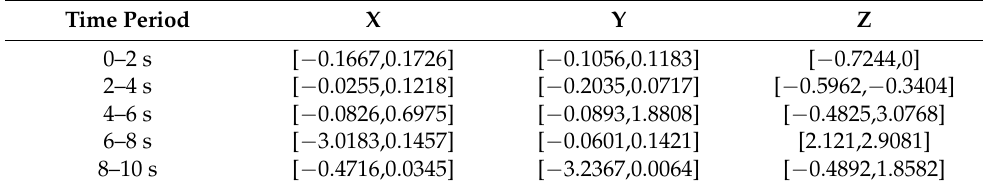
Table 5. The range of displacement error for each time period of robot simulation motion.